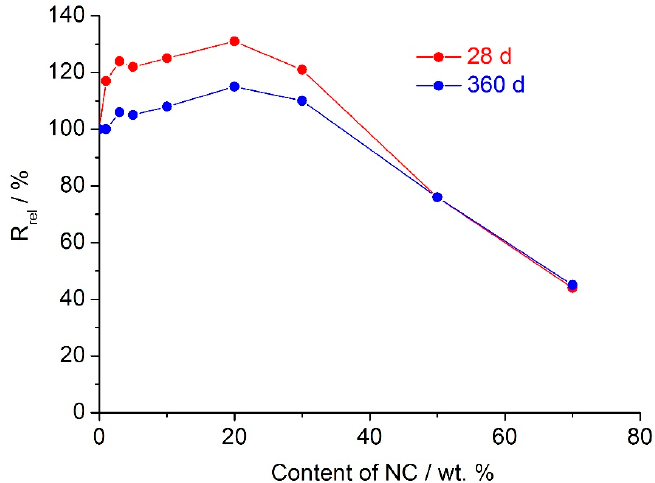
Figure 5. Variation of the relative compressive strength (R rel ) of the mechanically activated Portland cement–nepheline concentrate blend at 28 and 360 d of age as a function of percentage mass of the nepheline concentrate in the blend.